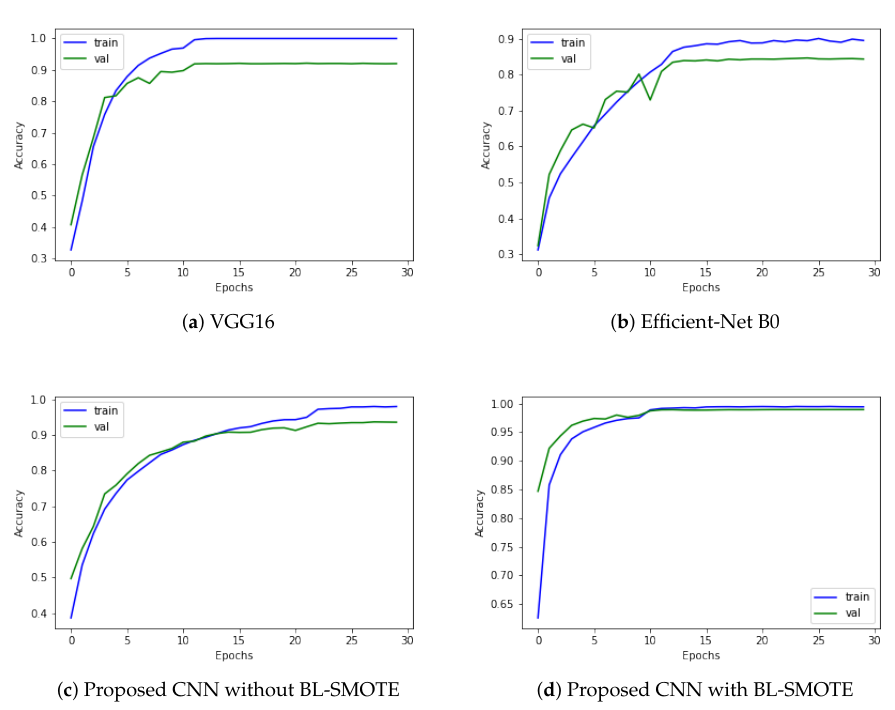
Figure 7. Significant improvement in accuracy scores with or without up-sampling of proposed model as compared to other state-of-the-art